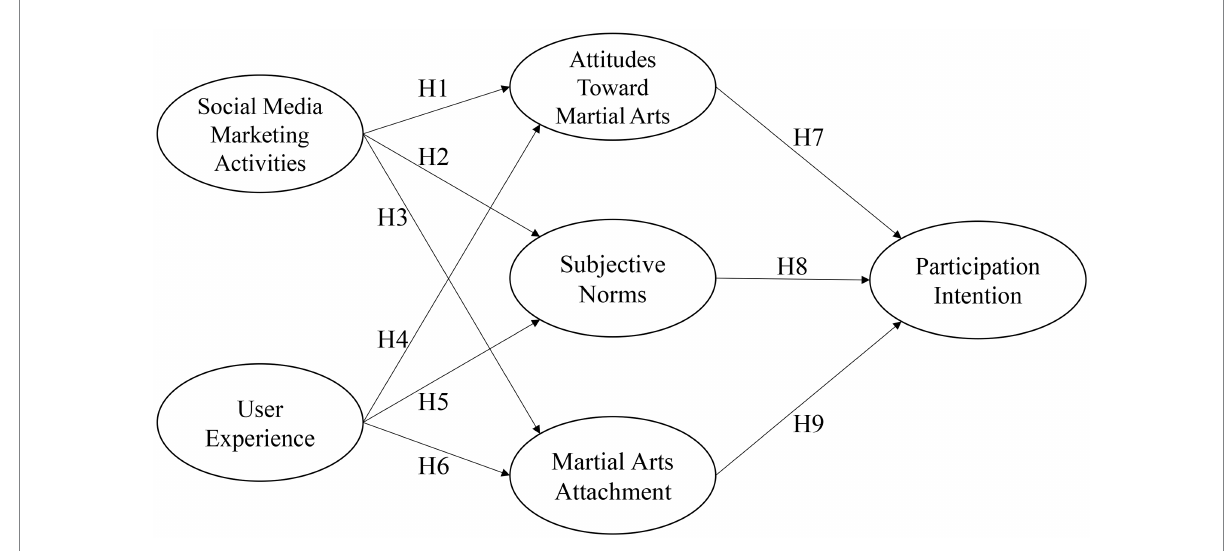
FIGURE 1 Research